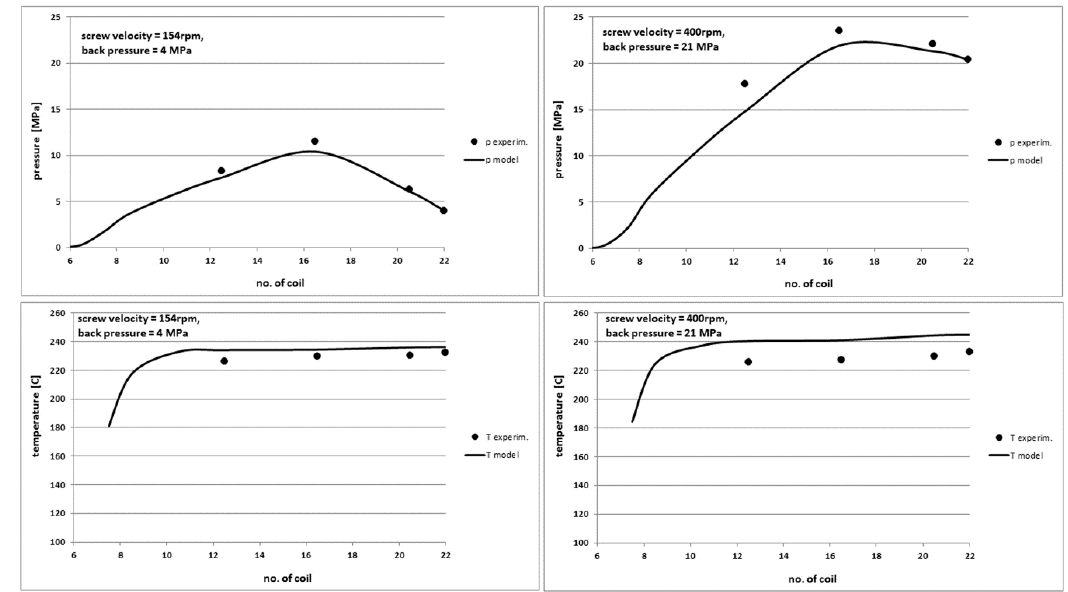
Figure 16. Comparison of theoretical and experimental characteristics of pressure ( top ) and temperature profiles ( bottom ) on the screw channel length in PP injection process for the screw rotational velocity of 154 rpm and the back pressure of 4 MPa ( left ) and 400 rpm and 21 MPa ( right ).